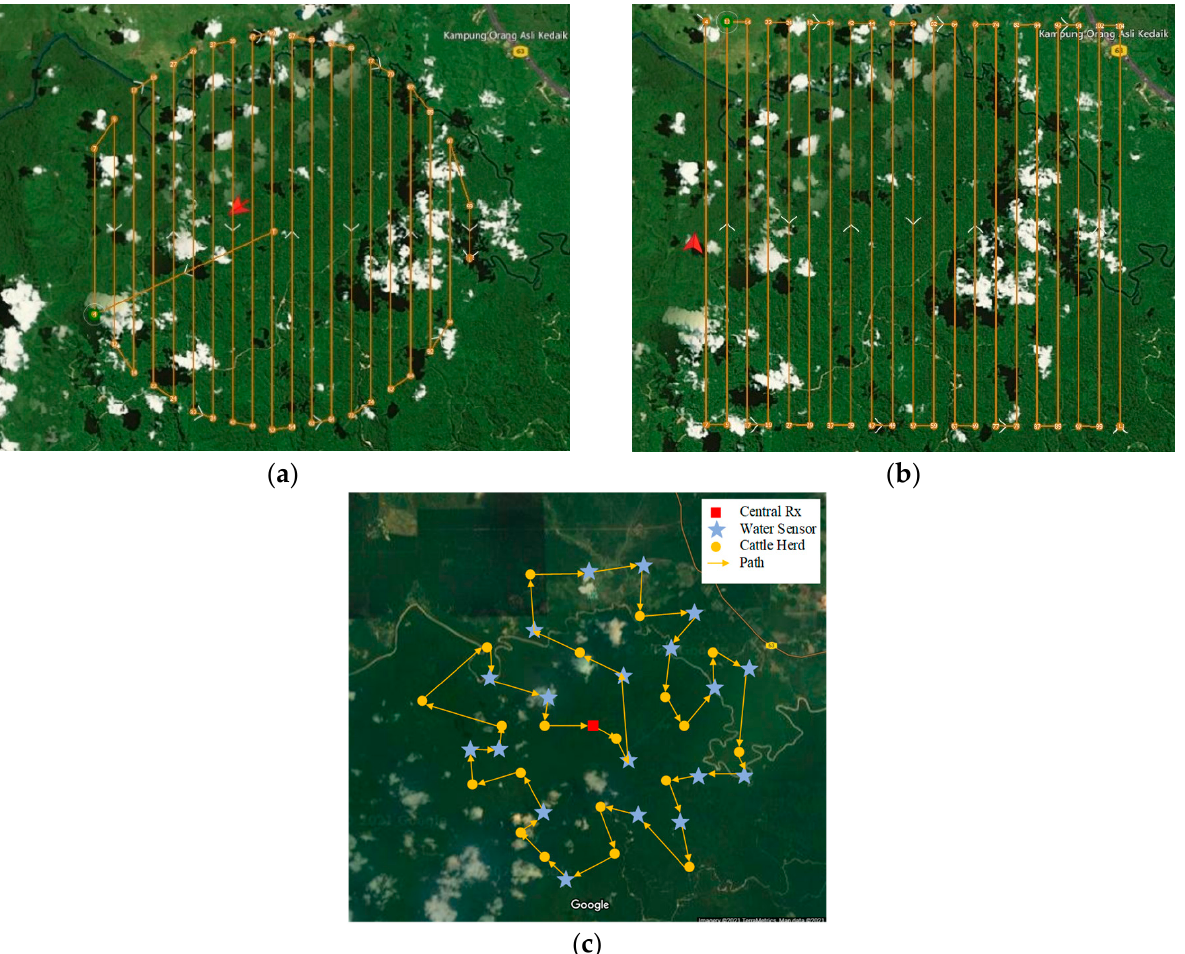
Figure 21. ( a ) Circular model path planning, ( b ) square model path planning, and ( c ) optimized path planning.